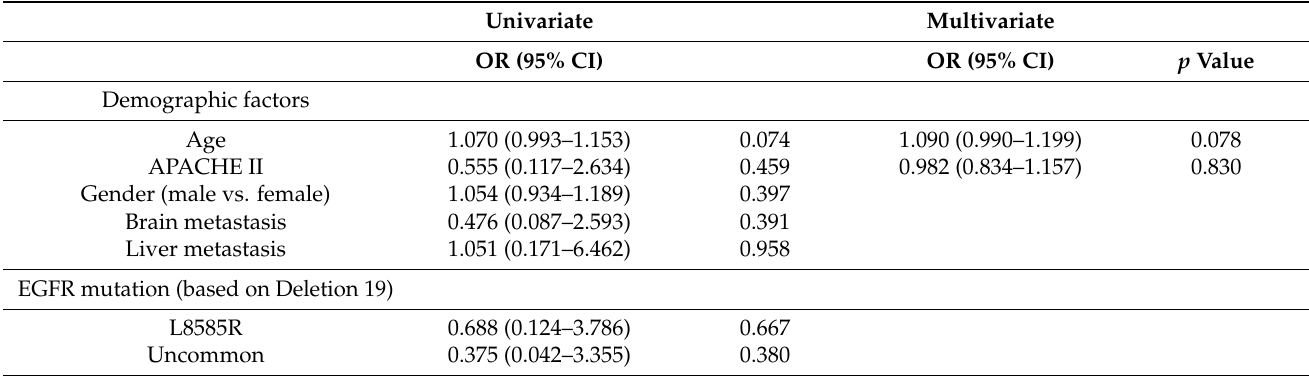
Table 2. Univariate and multivariate analysis of clinical factors associated with 28-day ICU survival. Univariate Multivariate OR (95% CI) OR (95% CI) p